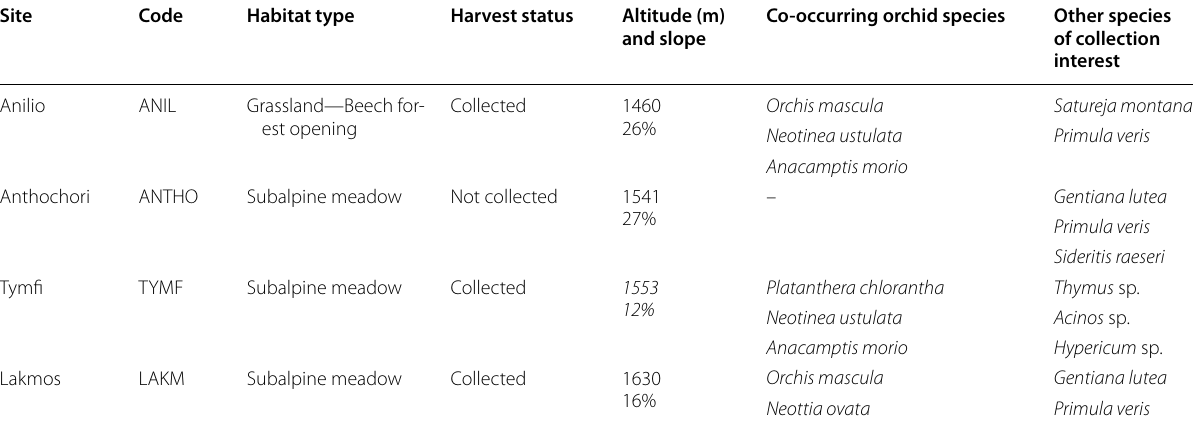
Table 4 Description of sampling sites